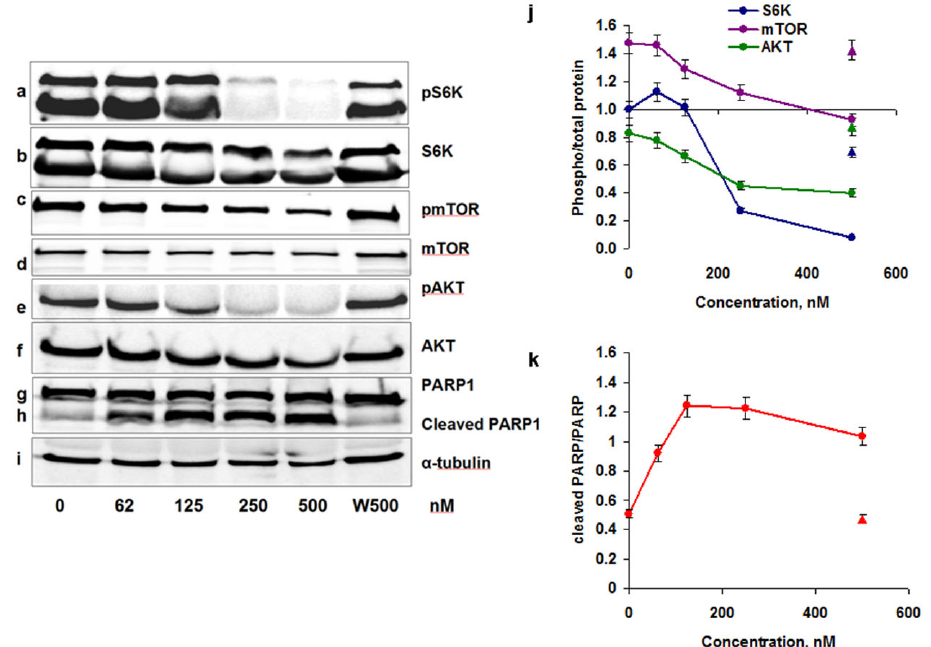
Figure 4. Compound 7c suppresses the PI3K/Akt/mTOR signaling pathway. ( a – i ) MCF7 cells were treated with different concentrations of 7c or 500 nM wortmannin (W) for 24 h. Cell lysates were immunoblotted with antibodies against PI3K/Akt/mTOR-related total or phosphorylated (p) proteins ( a – f ) and PARP1/cleaved PARP1 ( g , h ). ( i ) Control α -tubulin. ( j , k ) The ratios of p-proteins to total ones for compound 7c (circles) or wortmannin (triangles) ( j ) and cleaved PARP1 to full PARP1 ( k ) as measured by ImageJ program from two independent experiments.